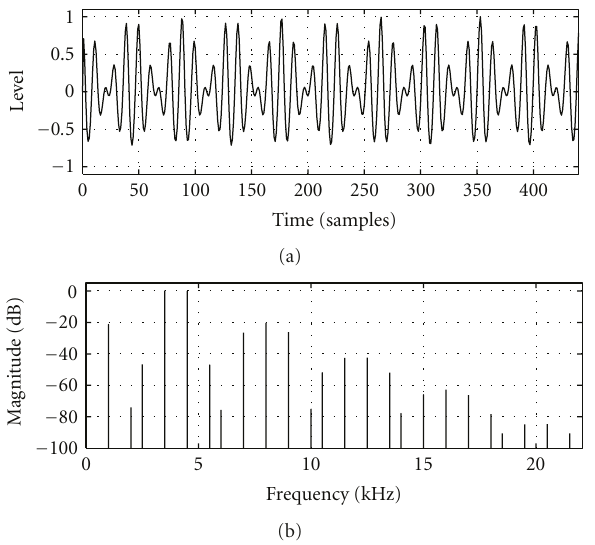
Figure 14: Heterodyne FBAM variation 3-II ( f 0 = 500Hz, β = 0 . 3, cosine carrier frequency 4000 Hz (8:1 ratio)), see Figure